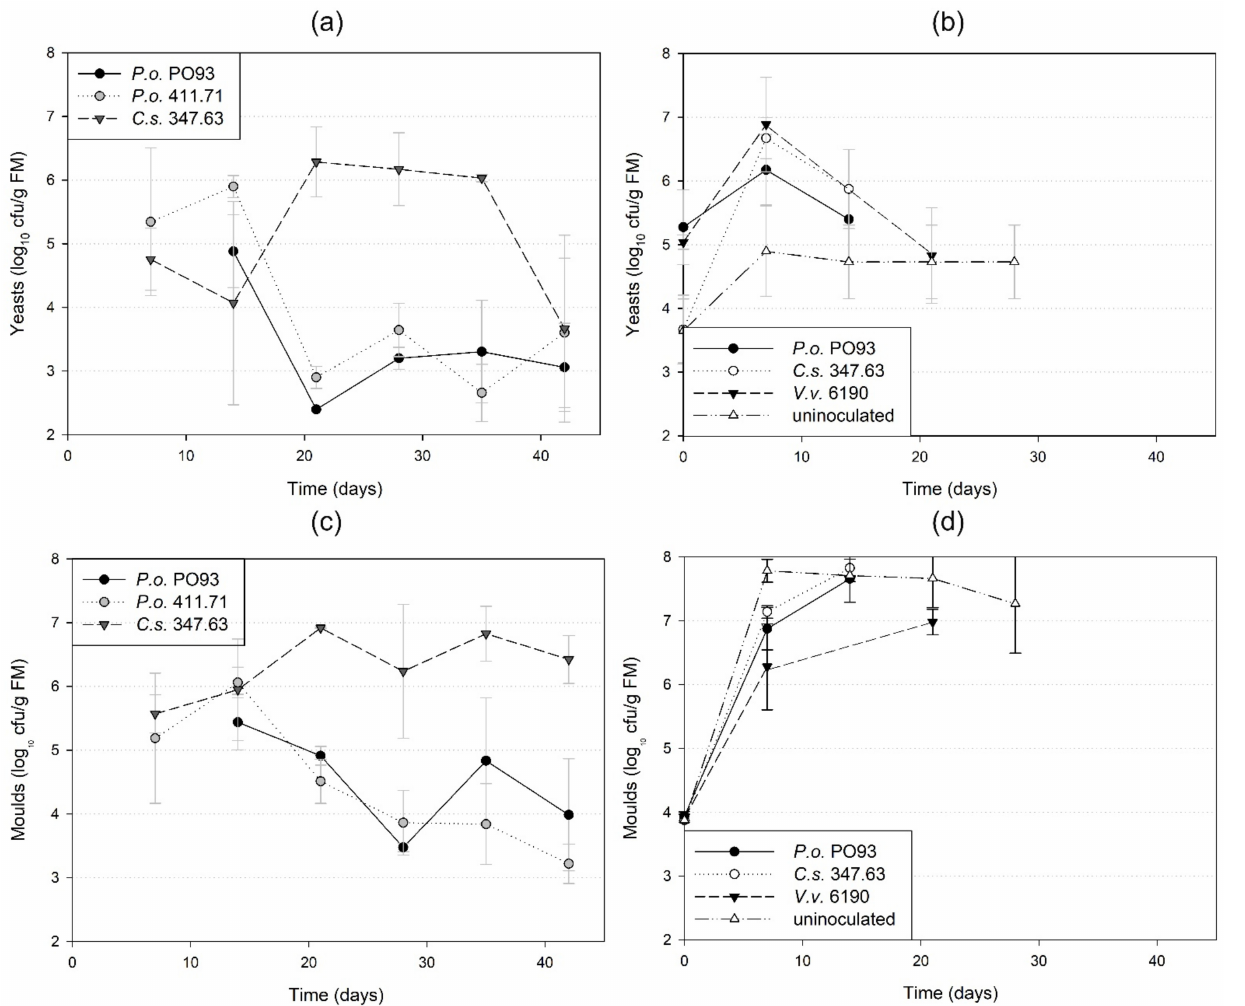
Figure 3. Number of yeasts and molds found on the straw treatments during incubation. Yeasts in ( a ) drained, ( b ) remoistened straw. Molds in ( c ) drained, ( d ) remoistened straw. P.o. — Pleurotus ostreatus ; C.s. — Ceriporiopsis subvermispora ; V.v. — Volvariella volvacea . Error bars indicate the standard deviation